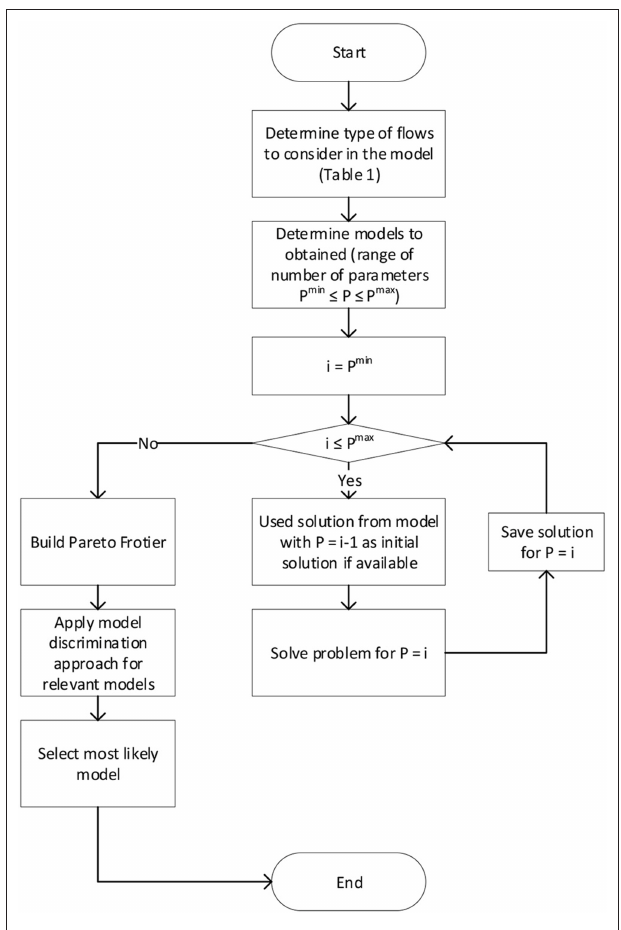
FIGURE 2 | Flow diagram summarizing the proposed